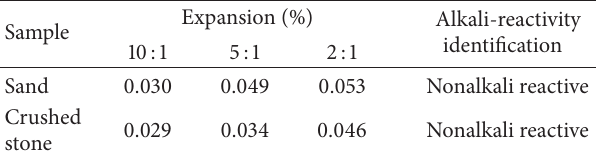
Table 4: Test results of alkali reactivity of